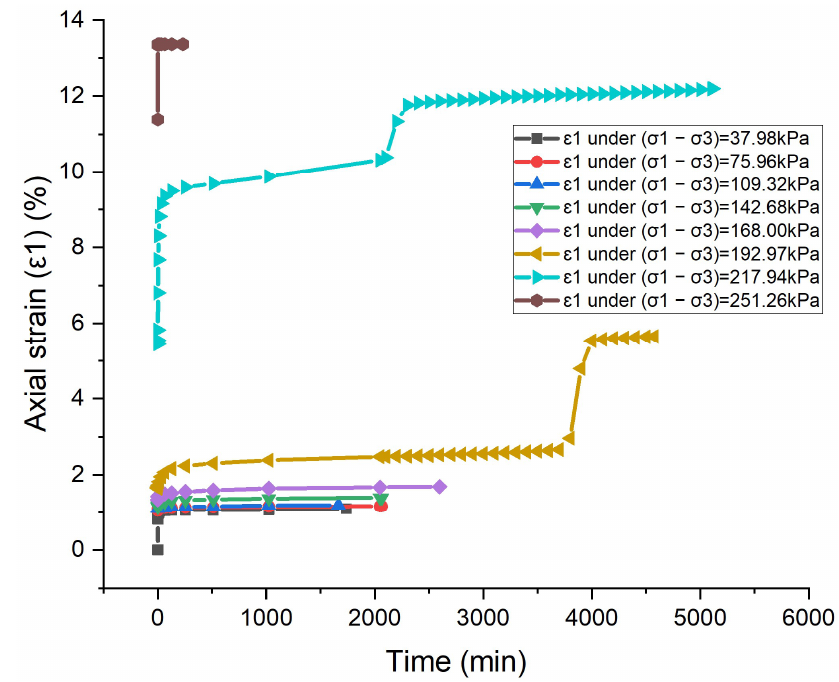
) –time curve of No. 12, 4 FTHs. (cid:2869)